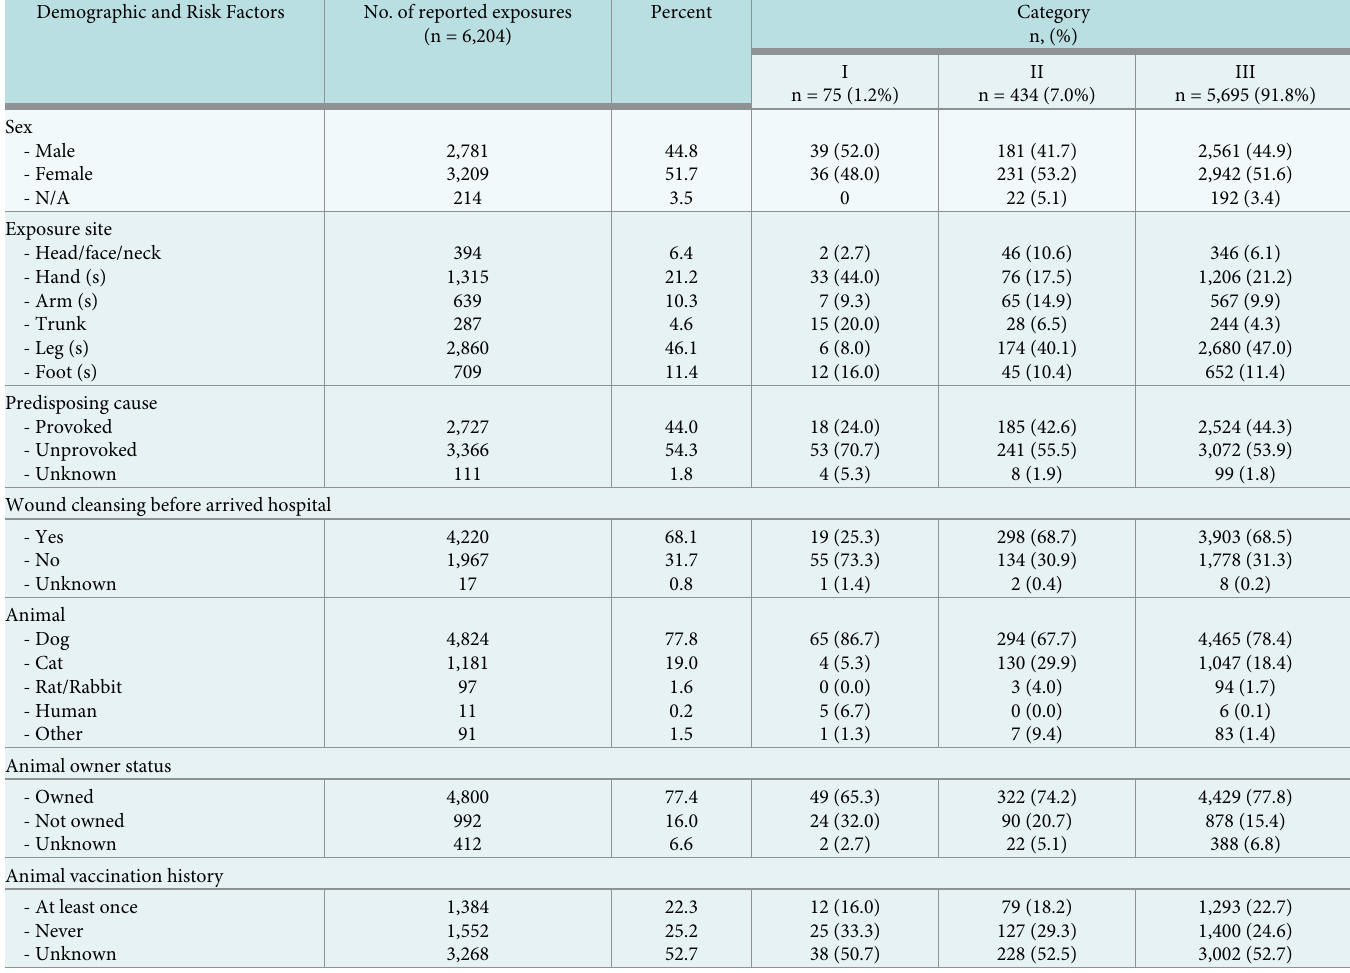
Table 3. Characteristic of suspected rabies exposures in Eastern Thailand reported to R36, 1 st Jan– 31 st Dec 2015. Demographic and Risk Factors